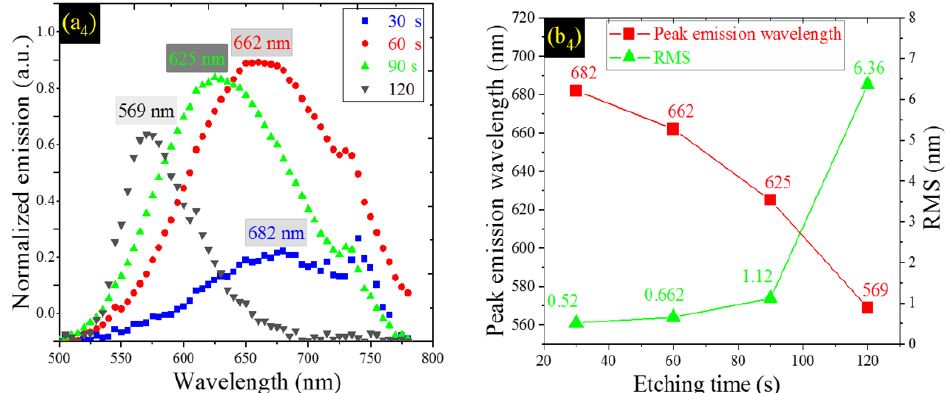
Figure 3. FESEM images (top view) together with the reflectance spectra (yellow curves) of PSi etched for ( a 1 ) 30, ( b 1 ) 60, ( c 1 ) 90, and ( d 1 ) 120 s. FESEM image (cross-section) together with the Tauc plots (yellow curves) of PSi etched for ( a 2 ) 30, ( b 2 ) 60, ( c 2 ) 90, and ( d 2 ) 120 s. ( e ) Etching time-dependent variation of versus bandgap energy and average thickness of PSi layers. ( f ) Etching time-dependent variation in the RMS roughness and percentage R of PSi. AFM scan of 10 × 10 μ m area at 1 Hz of PSi etched at times of ( a 3 ) 30, ( b 3 ) 60, ( c 3 ) 90, ( d 3 ) 120 s. Etching time-dependent ( a 4 ) PL spectra and ( b 4 ) peak emission wavelength and RMS roughness of PSi.